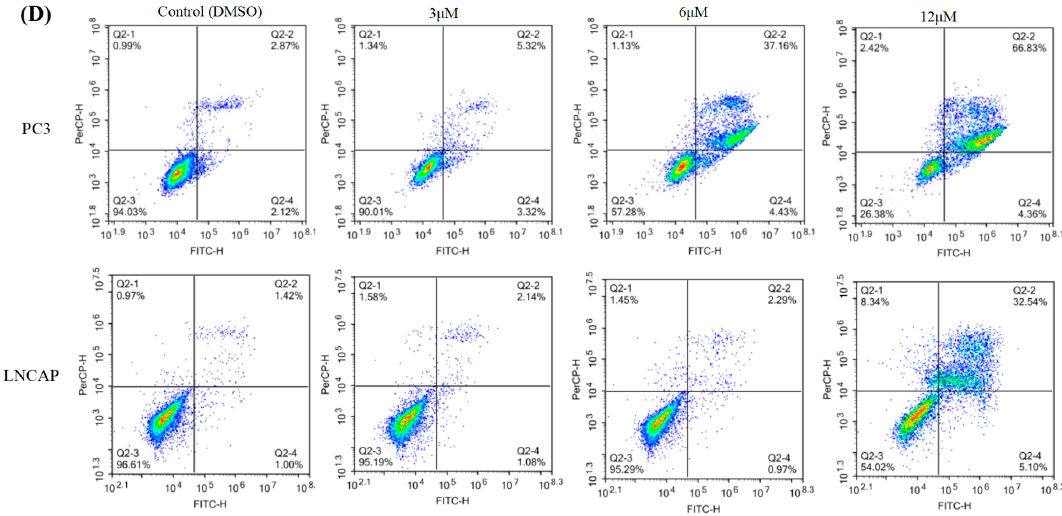
Figure 1. Effects of 2-((Glycine methyl ester)methyl)-naphtho[1,2-b]furan-4,5-dione ( TC7 ) on PCa cell growth and apoptosis. ( A ) Growth inhibition induced by TC7 on PC3 and LNCAP cells by MTT assay. IC 50 values ( μ M) of TC7 were determined according to these curves at different incubation times. ( B ) Cell number and morphological appearance of the two types of cells treated with TC7 at 3, 6, and 12 μ M observed by a fluorescent inverted microscope after 24 h. ( C ) DNA synthesis inhibition by TC7 on PCa cells by EDU-DNA assay. The zero-hour image was intended to demonstrate that the cells exhibited the higher level of DNA replication before treatment with TC7 . ( D ) Cell apoptosis induced by TC7 by flow cytometry. Scale bar = 100 μ M in all images. All experiments were performed in triplicate. Results are presented as mean ± SEM. * p < 0.05, ** p < 0.01 ( n = 3) compared with the control.